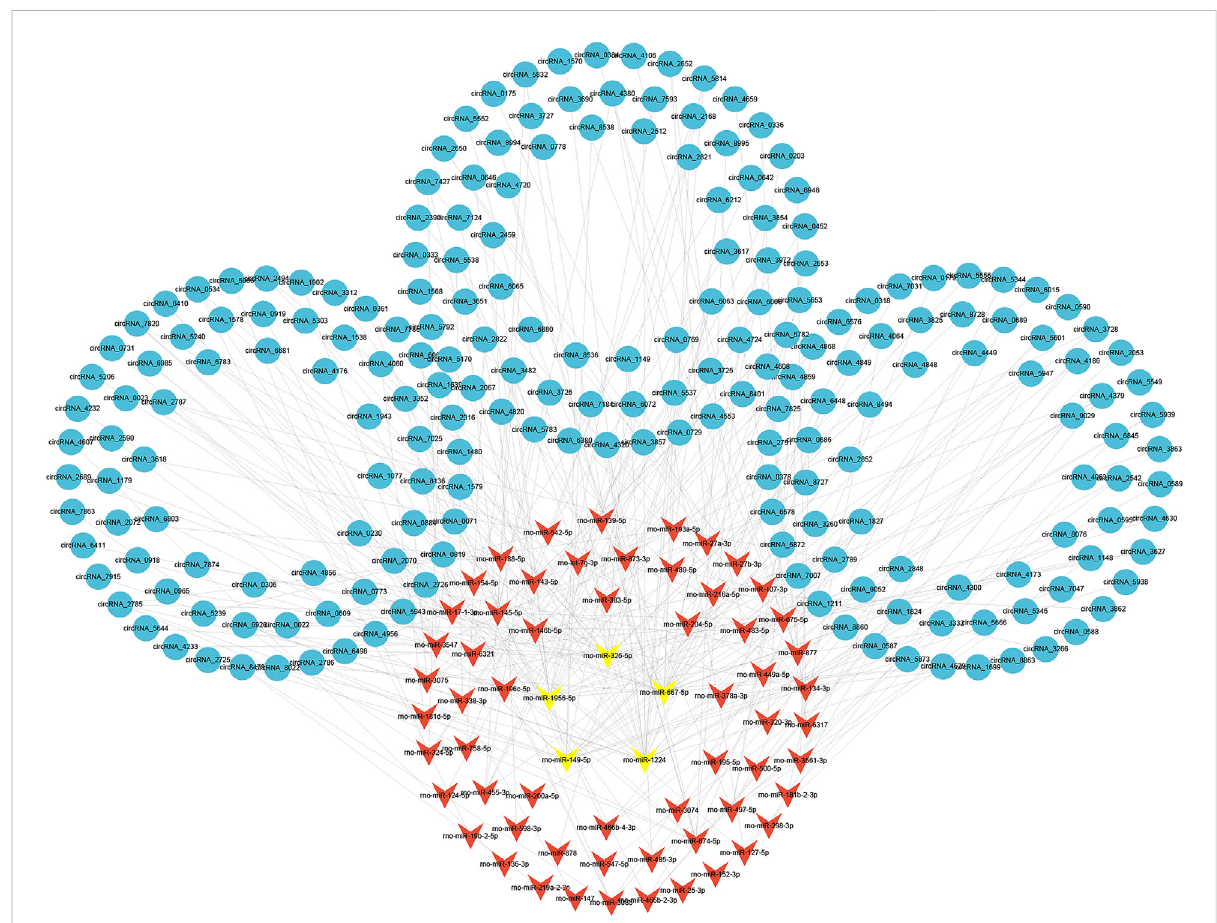
FIGURE 5 Construction of circRNA-miRNA network. The circRNA-miRNA interaction network for differentially expressed circRNAs. The top fi ve miRNAs targeted by a larger number of circRNAs are marked in yellow. circRNAs, circular RNAs; miRNAs,